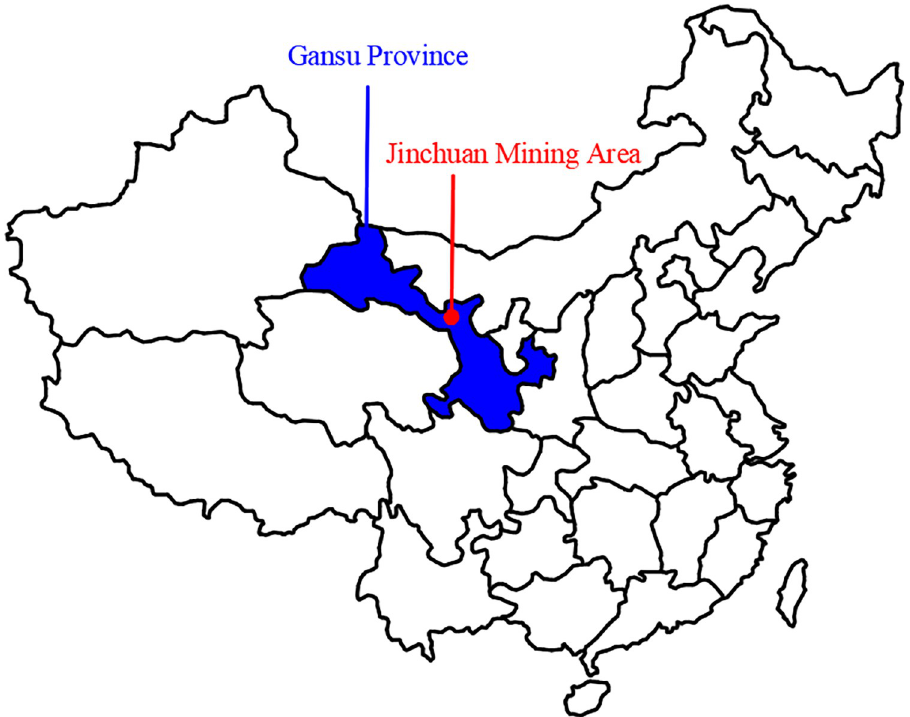
Fig 2. Location of Jinchang City in China.